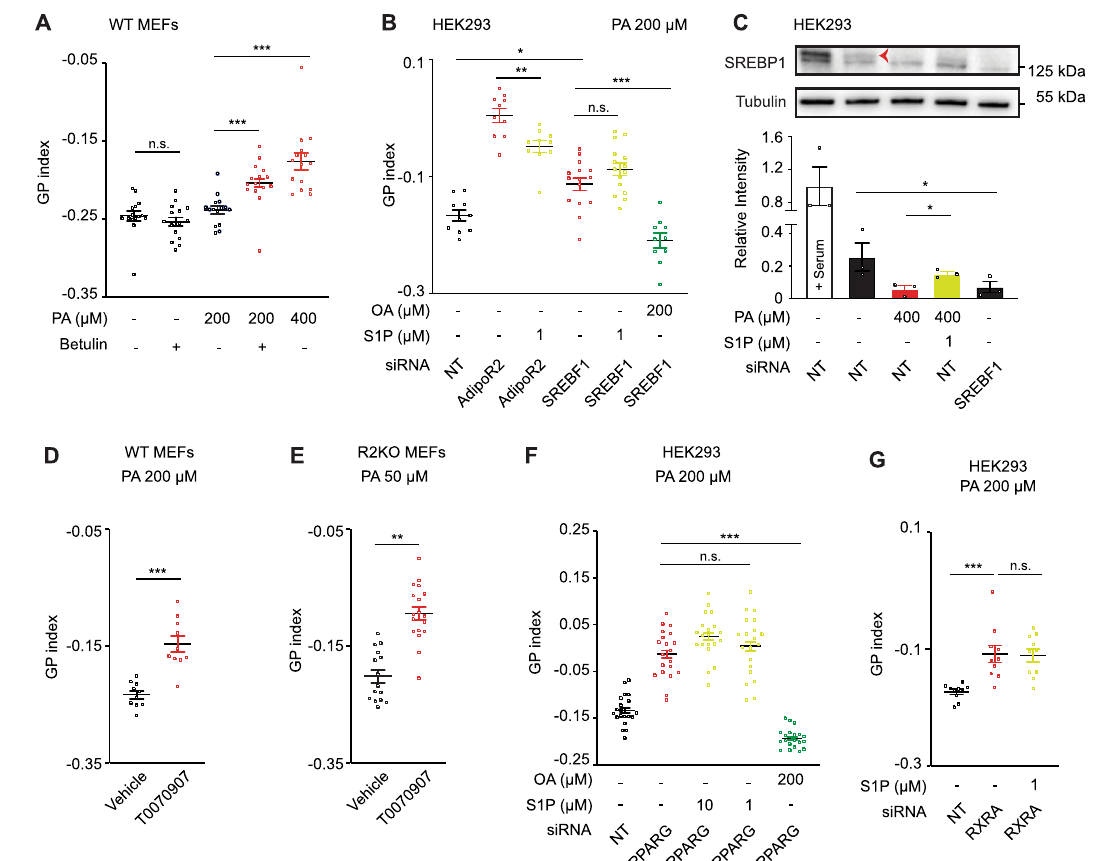
Fig. 5 | S1P signaling via SREBP1 and PPAR γ maintains membrane homeostasis in human/mouse cells. A Average GP index from several images of WT MEFs treated with vehicle, betulin 1 μ M (inhibitor of SREBP maturation) and PA 200 μ M±betulin 1 μ M. n =15 separate images analyzed for each condition. B AverageGPindexfromseveralimagesofNT,AdipoR2andSREBF1siRNAHEK293 cells treated withPA 200 µ M ± S1P 1 µ M and ± OA 200 µ M. For eachconditionfrom left to right, n =10, 10, 10, 15, 15 and 10 separate images analyzed. C Western-Blot and quanti fi cation ( n =3 experiments) of NT and SREBF1 siRNA HEK293 cells treated with vehicle and PA 400 µ M ± S1P 1 µ M. The red arrow points to the pre- cursor SREBP1 band. Note the presence of an unspeci fi c band just below SREBP1 band. n =3 biologically independent replicates per condition. Uncropped blots in Source Data. D , E Average GP index from several images of WT and R2KO